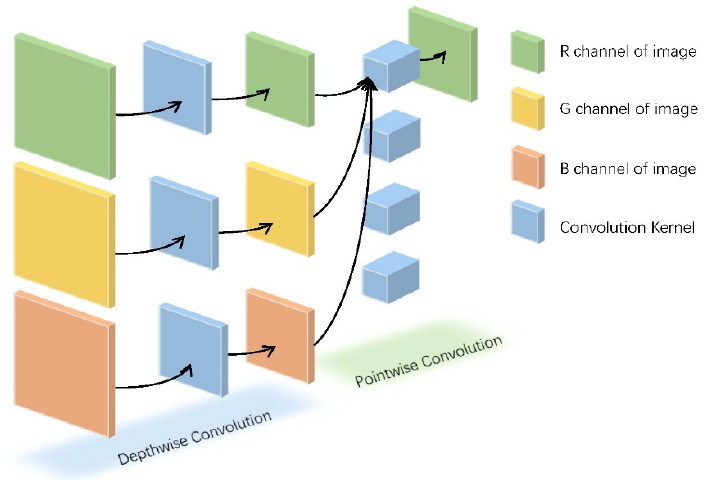
Figure 11. Depth-level separable convolution structure of MobileNet. Table 4. Performance of different models on ImageNet.